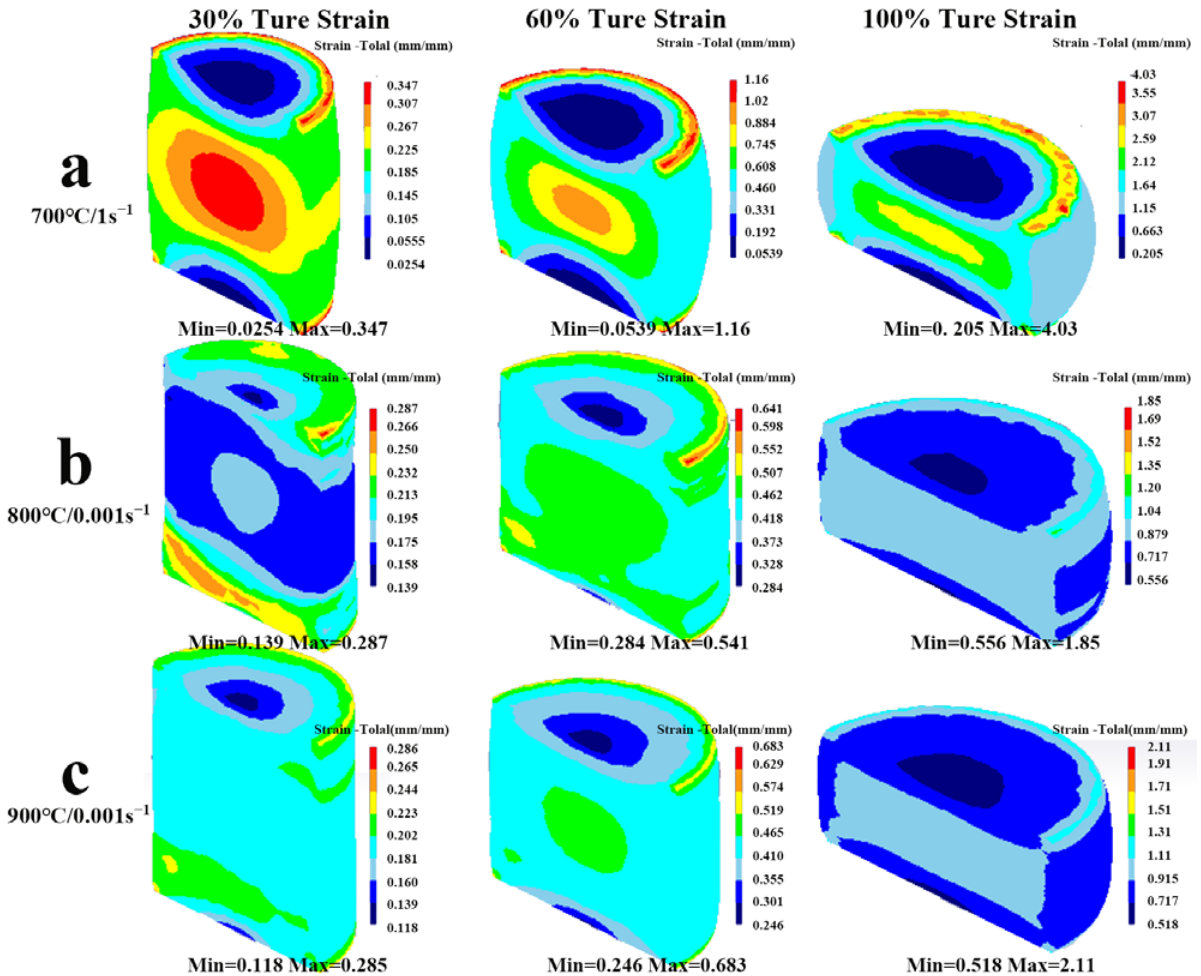
Figure 13. Simulation and prediction of the effective strain distribution of the Cu − 9Ni − 6Sn alloy under 30%, 60%, and 90% of the true strain at ( a ) 700 ℃ /1 s − 1 , ( b ) 800 ℃ /0.001 s − 1 , and ( c ) 900 ℃ /0.001 s − 1 .